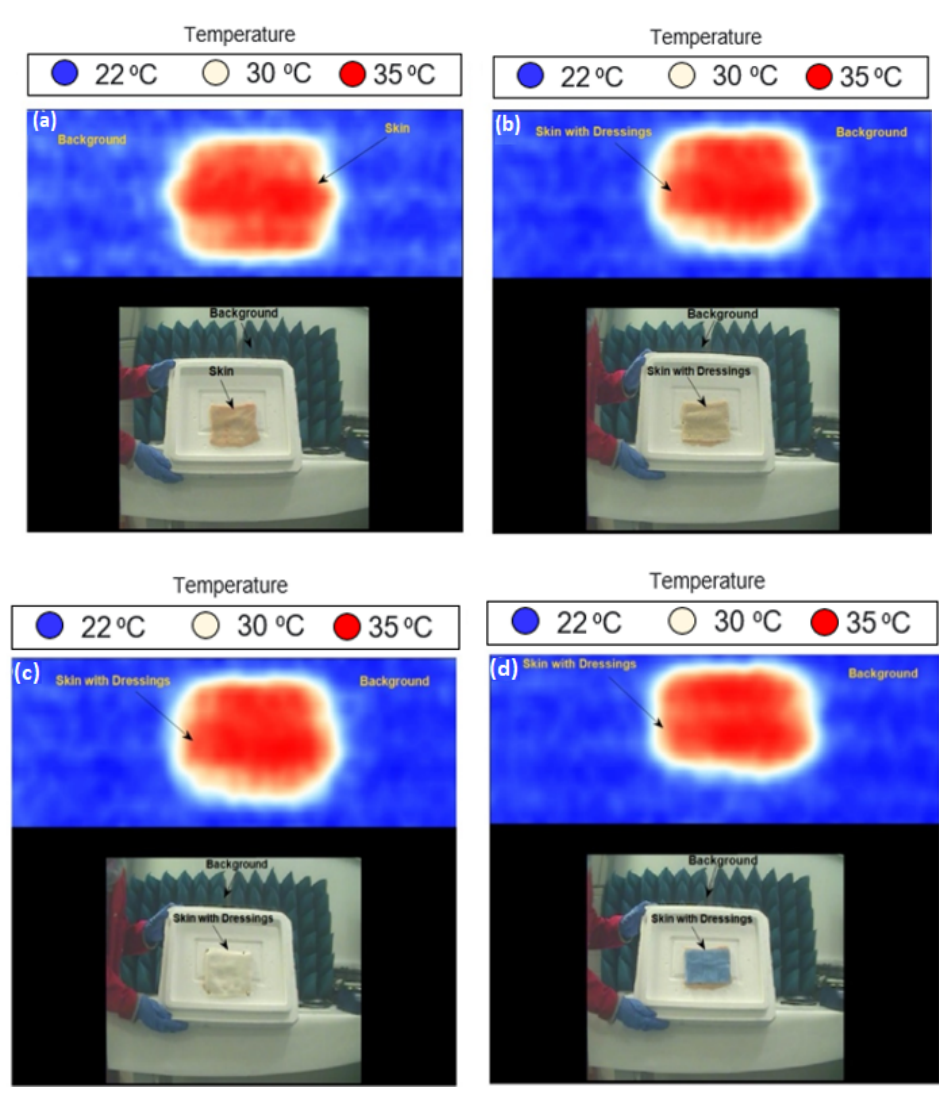
Figure 7. MMW images for porcine skin sample at 250 GHz; ( a ) represents the skin without dressings, ( b ) represents the skin with one-layer light support bandage, ( c ) represents the skin with 10-layer white gauze burn bandage, and ( d ) represents the skin with 4-layer blue gauze burn bandage. Each image has 229 (w) × 277 (h) pixels, and it takes 5 s to take a screenshot of an image.